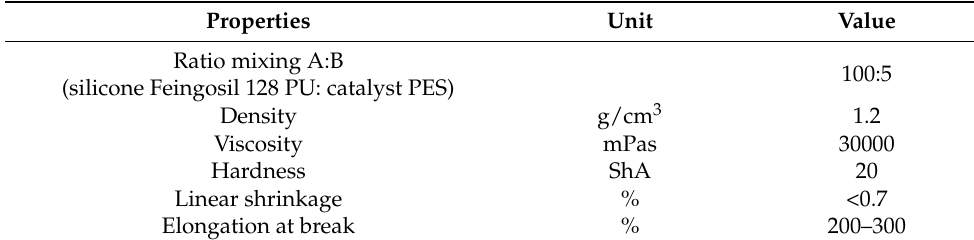
Table A6. Properties of silicone Feingosil 128 PU